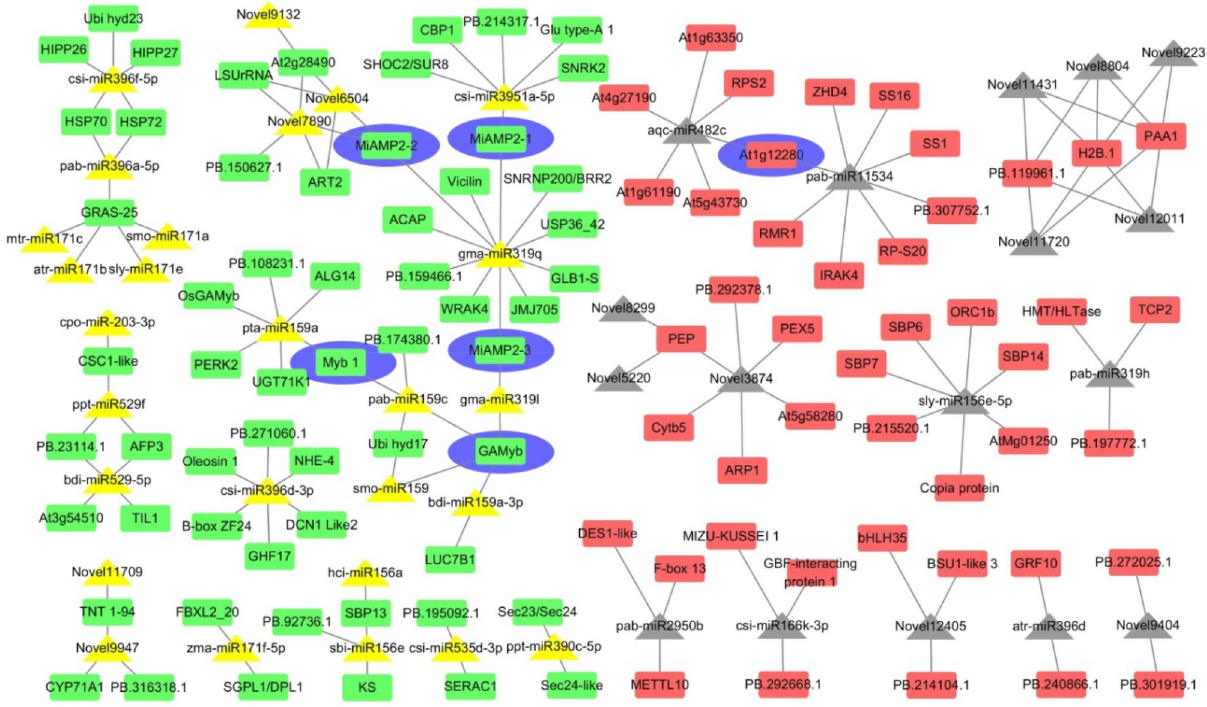
Figure 6. miRNA–mRNA interaction network. The miRNA–mRNA interaction network map was generated by Cytoscape (v3.6.0). Triangles represent miRNAs; rectangles represent their target genes. The hub genes of the interaction network are highlighted in blue. Yellow and gray indicate up-regulated and down-regulated miRNAs, respectively. Red and green indicate up-regulated and down-regulated target genes,